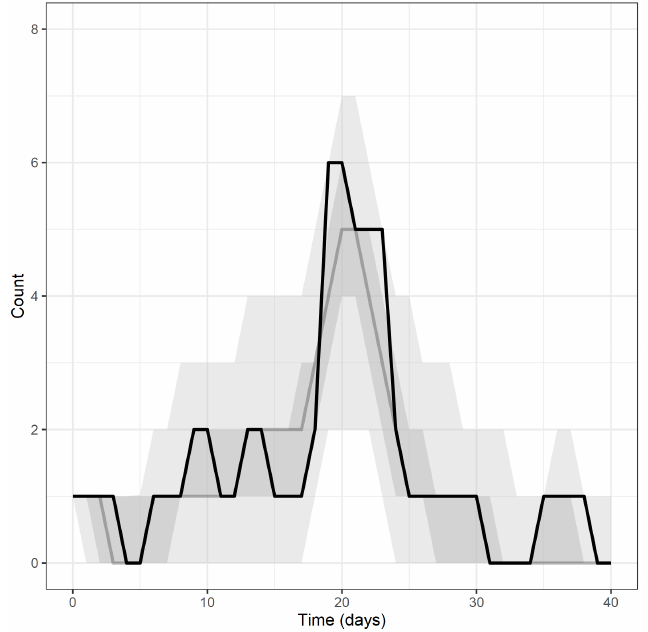
Figure 5. Line plot showing the number of infectious pigs as a function of the number of days since the onset of signs in the first affected pig (black line). Superimposed on this plot are the predicted median (grey line) number of infectious pigs per day. The dark and light shaded areas show the 50% and 95% quantiles around these estimates. The approximate posterior distribution differed markedly from the prior distribu- tions for all variables indicating that they were well informed by the data. For this out- break, the median of the average latent period was 10 days (95% HPD [highest posterior density interval]: 2 to 19 days), and the median of the average duration of infectiousness was 3 days (95% HPD: 2 to 4 days). The estimated median for the transmission coefficient was 3.3 (95% HPD: 0.4 to 8.9) infectious contacts per ASF-infectious pig per day. The esti- mated median for was 10 (95% HPD: 1.1 to 30). The Appendixes A–C provides details of the full approximate posterior 𝑑𝑑 0